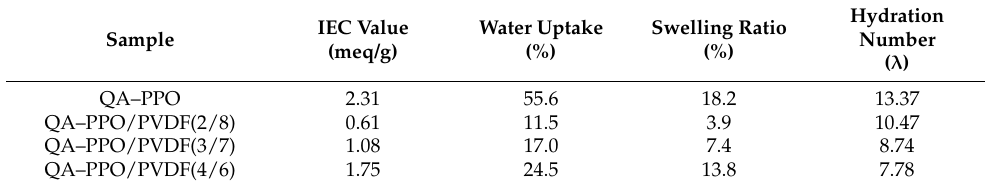
Table 2. The ionic parameters of